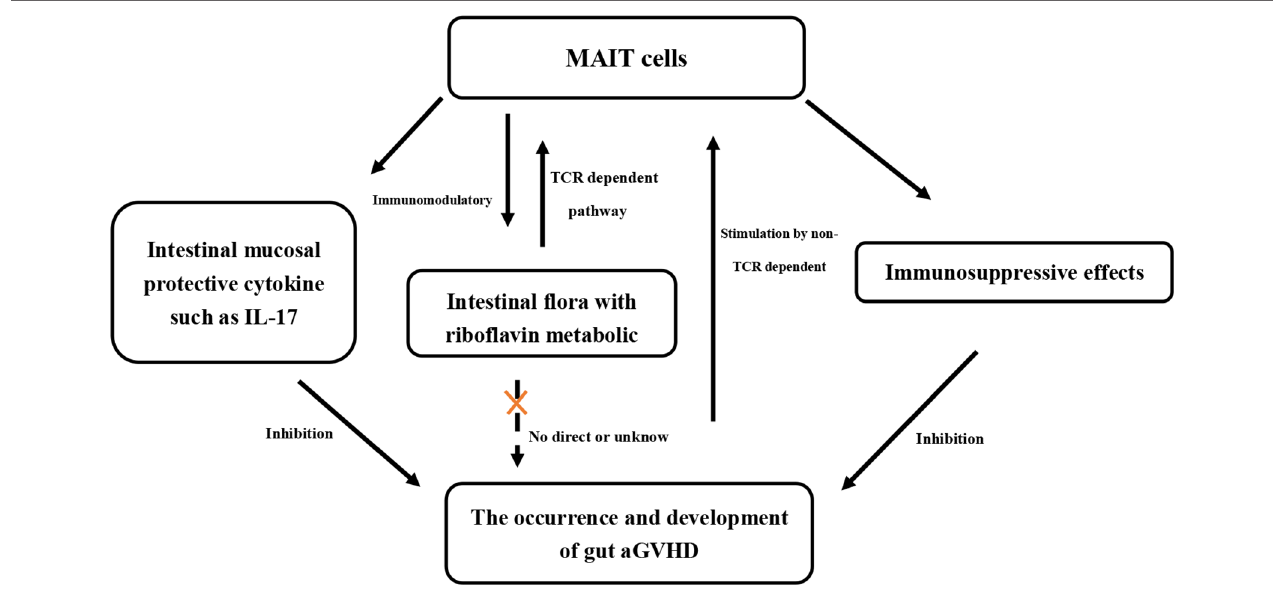
TABLE 2 | The relationship between MAIT cells, intestinal fl ora, and gut aGVHD in the